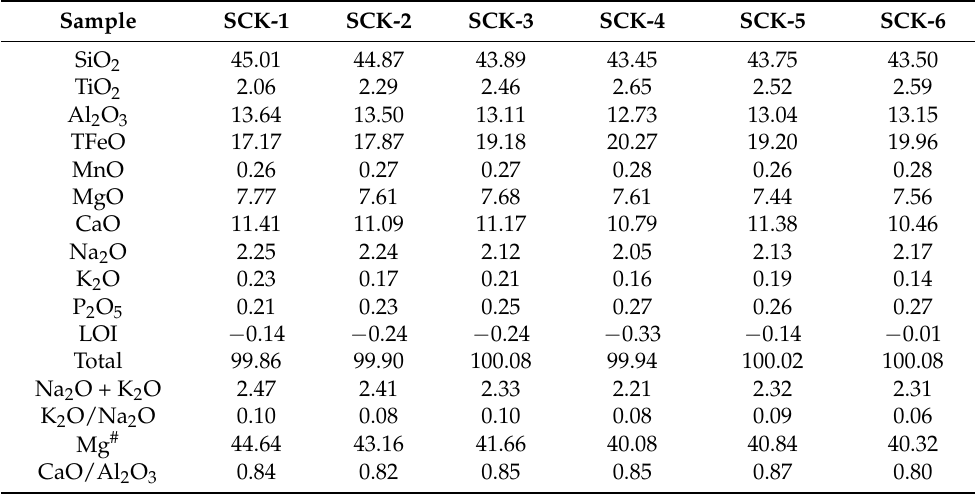
Figure 5. Zircon Hf-O isotopic compositions for the Sanchakou gabbros. ( a ) The ε Hf (t) versus 207 Pb/ 206 Pb age diagram; ( b ) The δ 18 O weighted average value distribution diagram. The Hf isotopic data of Xuwujia gabbronorites and Xigou gabbros are from [35,76]. Table 4. The whole-rock major elemental data (wt.%) of the Sanchakou